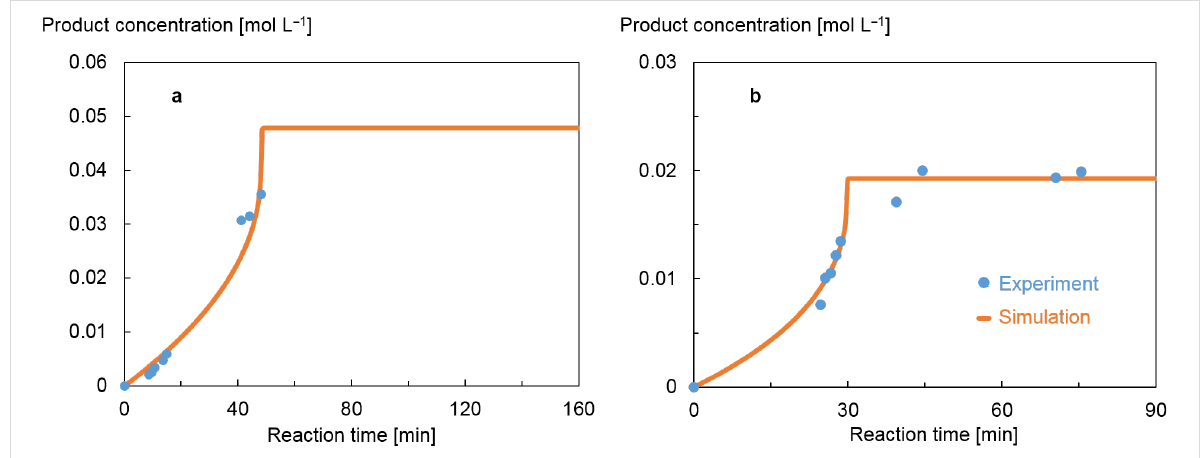
Figure 3: Results of experiments from the MBDoE in Table 2, conducted for parameter estimation, and their corresponding simulated model responses based on the estimated parameters. The only experiments conducted were those calculated by the MBDoE, defined by the sampling times and recipes suggested. (a) Experiment 4 conducted at a reference temperature of 70 ºC to estimate rate constants. (b) Experiment 8 used for deter- mining activation energies, at 75